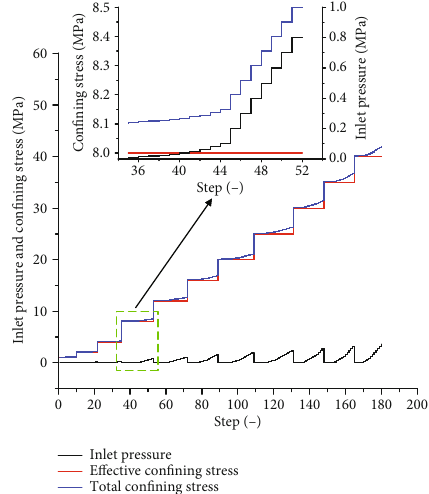
Figure 4: Planned progression of testing conditions.